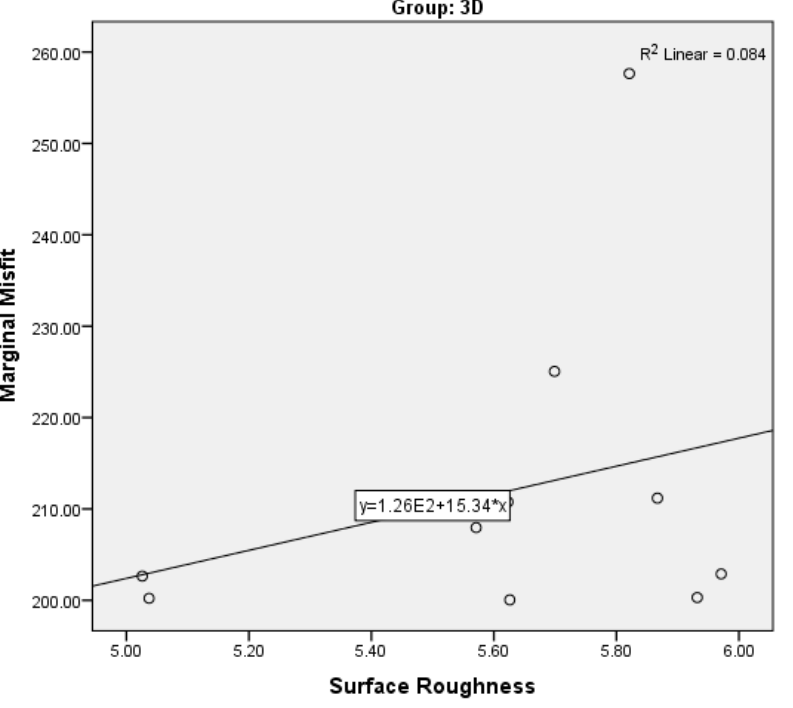
Figure 12. Scatter plot for the correlation between marginal misfit and surface roughness for the 3D 3D samples.